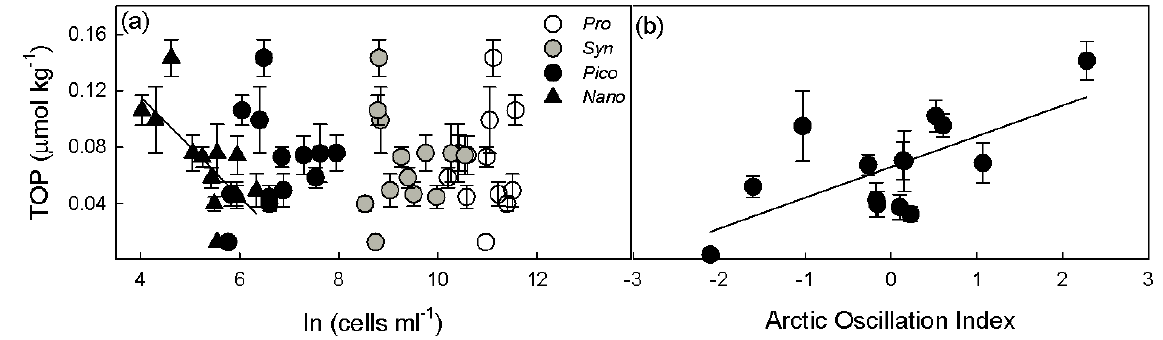
Figure 10. Relationship between TOP (December 2006–January 2008) and (a) cell abundances (natural log transformed) of Prochlorococcus , Synechococcus , picoeukaryotes and nanoeukaryotes during September 2006–November 2007. Among cell abundances, only nanoeukaryotes showed a significant relationship with TOP ( r 2 = 0 . 61, p < 0.001). Panel (b) : relationship between TOP and the Arctic Oscillation index during November 2005–December 2006 ( r 2 = 0 . 46, p <